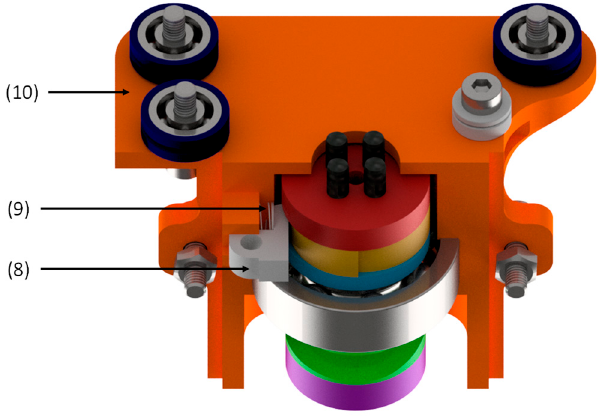
Figure 3. Shaft inside one half of the housing.